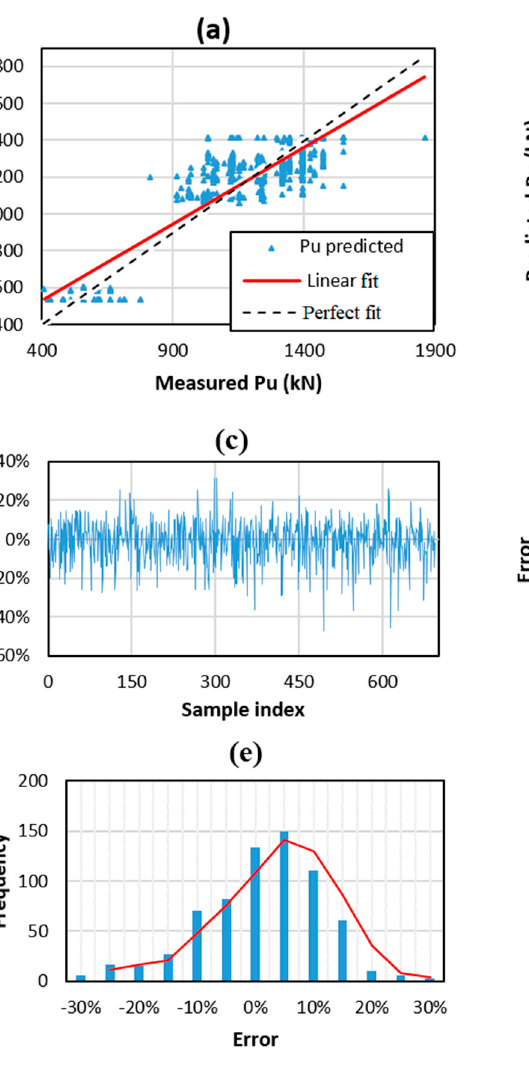
Figure 7. Graphs of regression results between measured P u versus predicted P u for the testing part using ( a ) ANN, ( b ) RF, ( c ) mean error ANN, ( d ) mean error RF, ( e ) standard deviation ANN, and ( f ) standard deviation RF. Table 5. Summary of prediction capability